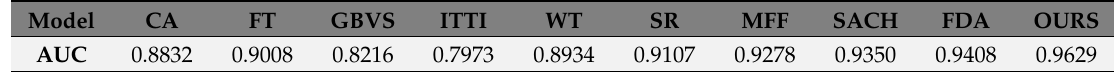
Table 1. The Area Under the Curve (AUC)s of our proposed model and nine competing models on SPOT 5 images.